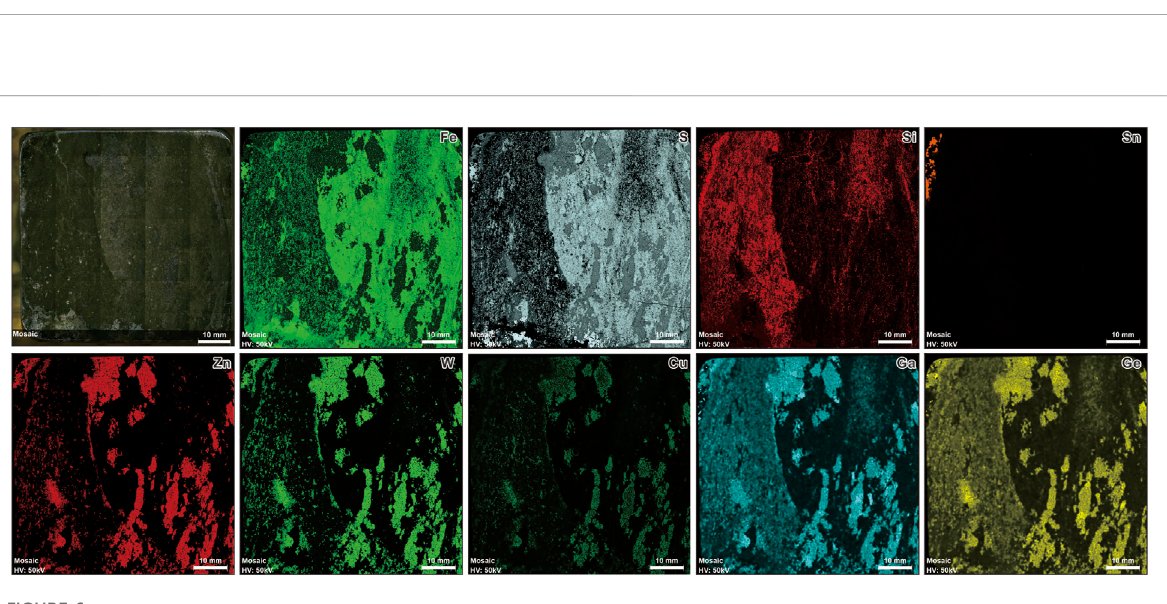
FIGURE 6 Photograph and corresponding μ -XRF single-element maps (Fe, S, Si, Sn, Zn, W, Cu, Ga, Ge) of rock slab